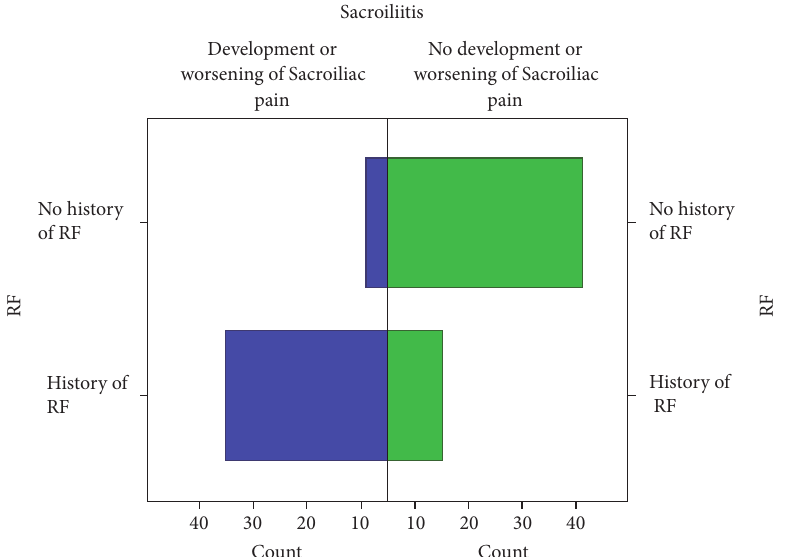
Figure 2: Incidence of Sacroiliac joint pain was 70% among patients with recent history of Lumbar Radiofrequency procedure compared to 18% among those without a recent history of the procedure.